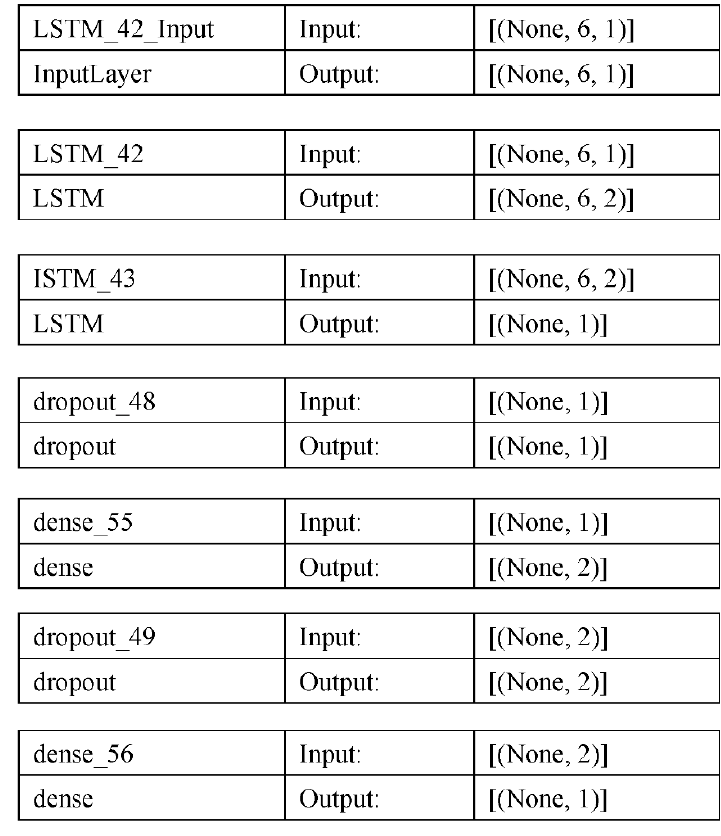
Figure 9. The model architecture of the proposed model.